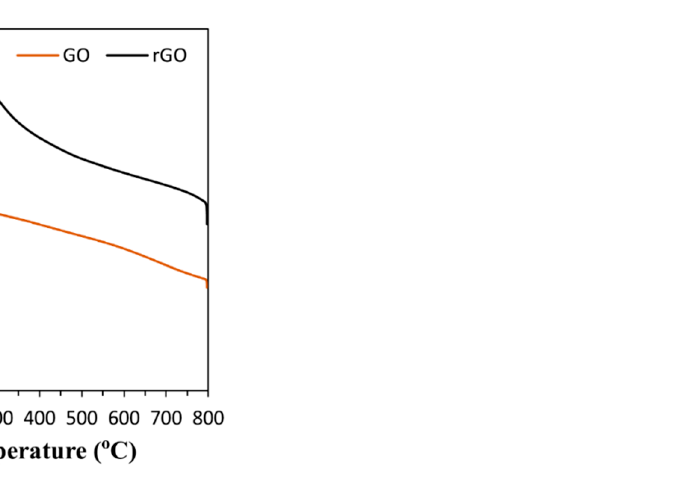
Figure 10. TGA curves of GO and rGO synthesized using lemon juice (heating rate = 10 ◦ C /min, N 2 flow).